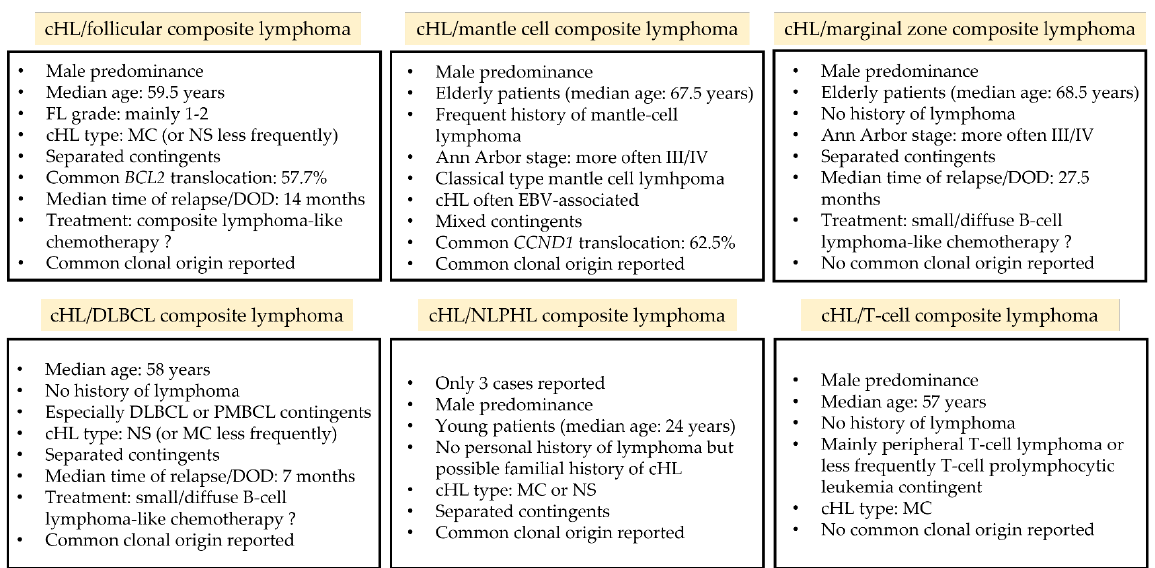
Figure 1. Key features of composite lymphomas associating a cHL with another lymphoma. cHL: classical Hodgkin lymphoma; DOD: death of disease; DLBCL: diffuse large B-cell lymphoma; EBV: Epstein–Barr virus; FL: follicular lymphoma; MC: mixed cellularity; M/F: male/female ratio; NLPHL: nodular lymphocyte-predominant Hodgkin lymphoma; NS: nodular sclerosis; PMBL: primary medi- astinal B-cell